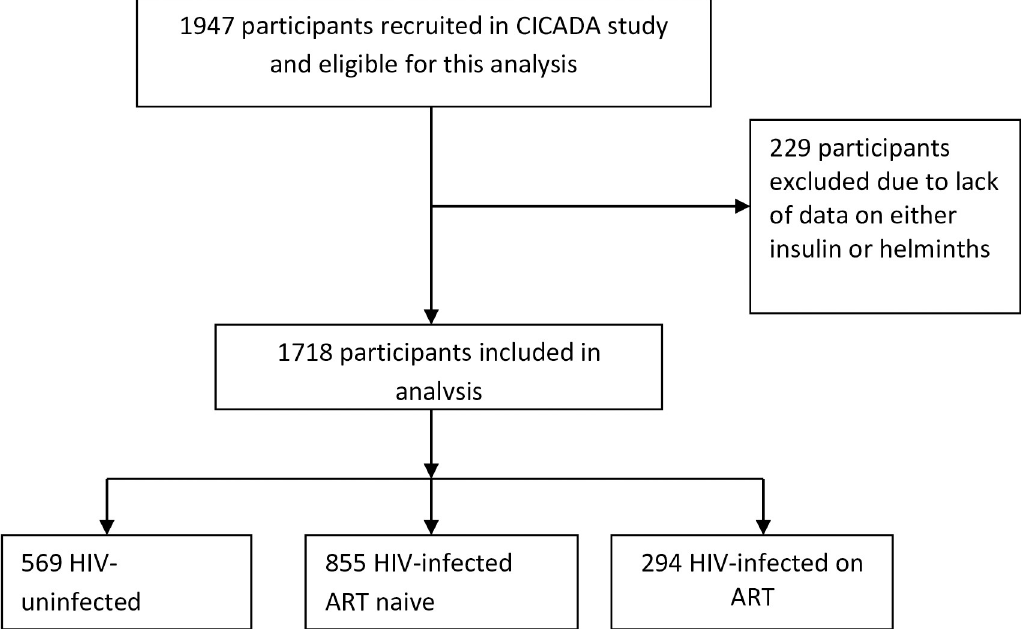
Fig 1. Study flow diagram. ART, Antiretroviral therapy; CICADA, the Chronic Infections, Co-morbidities and Diabetes in Africa.